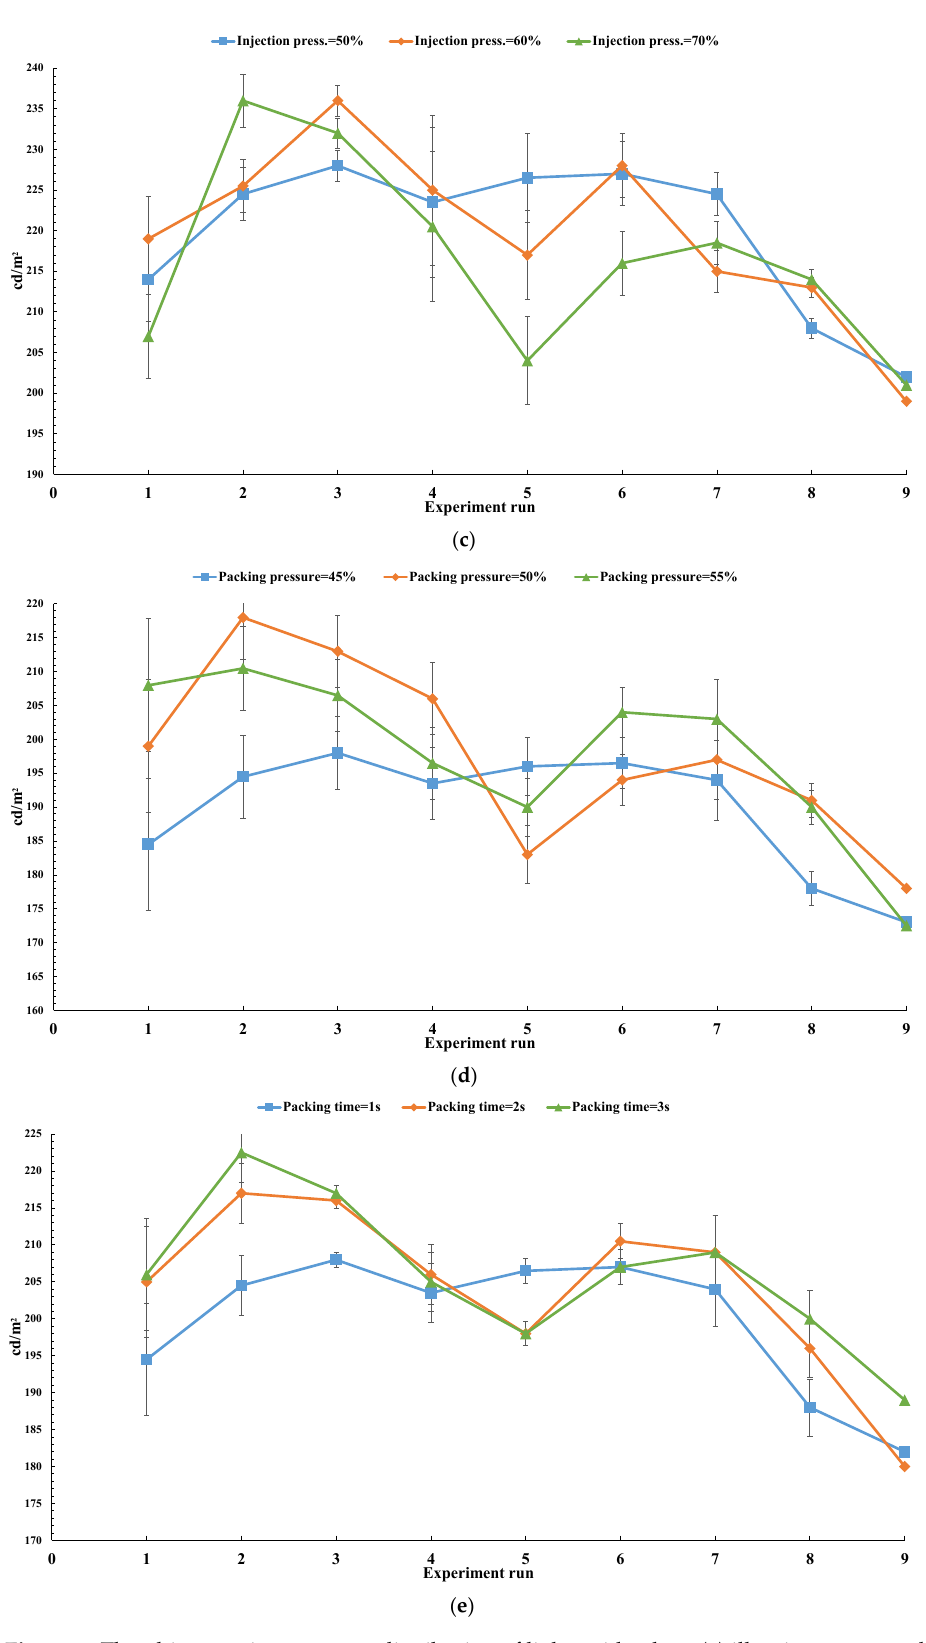
Figure 8. The ultimate microstructure distribution of light guide plate. ( a ) illuminance vs. mold temperature; ( b ) illuminance vs. melt temperature; ( c ) illuminance vs. injection pressure; ( d ) illuminance vs. packing pressure; ( e ) illuminance vs. packing time .